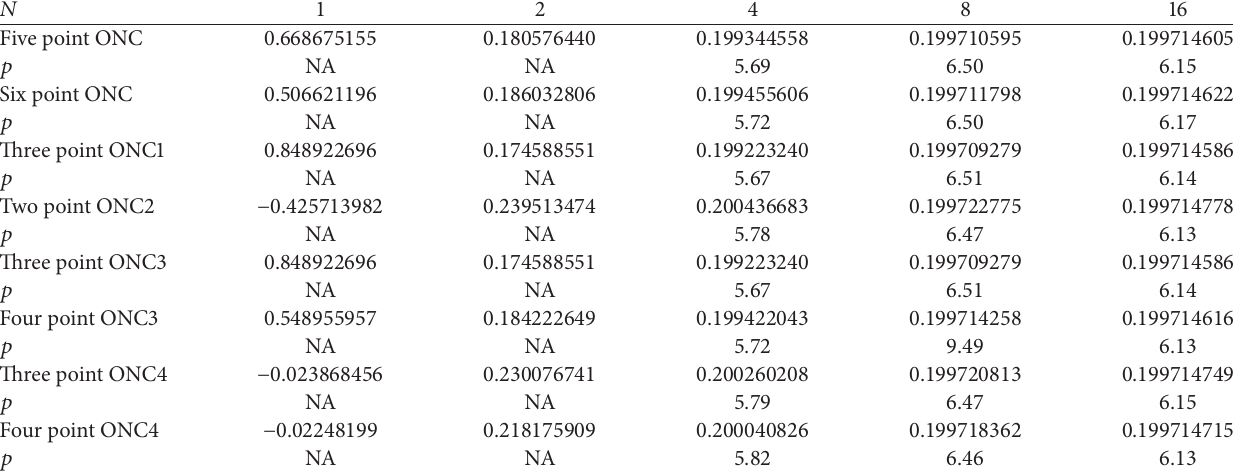
3 𝑒 −2𝑥 sin (4𝑥)𝑑𝑥 0